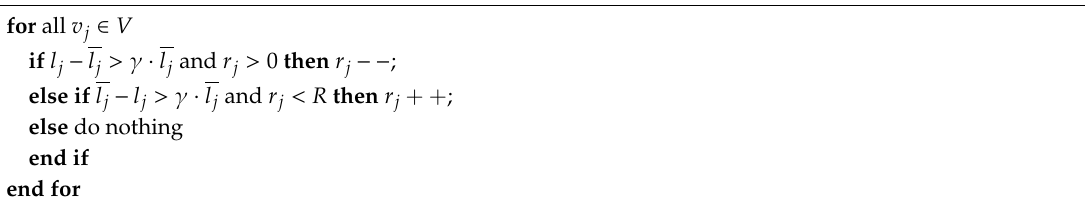
Algorithm 1 : Autonomous load regulation mechanism based on data relay radius control. for all v j ∈